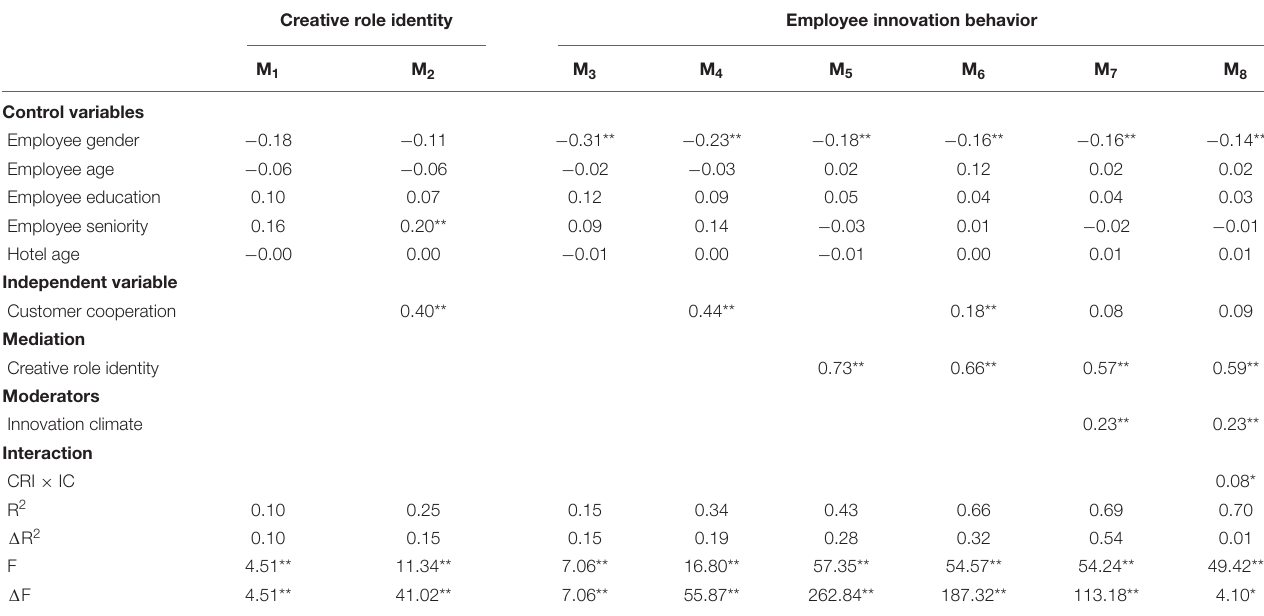
TABLE 4 | Results of hypotheses